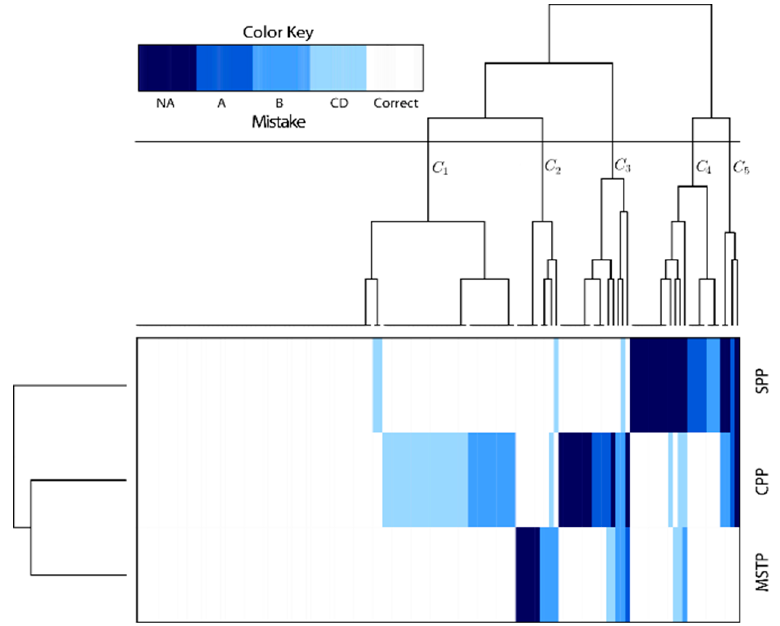
Figure 6. Heatmap clustering the students’ mistakes in the three problems in graph theory (source: own visualization).